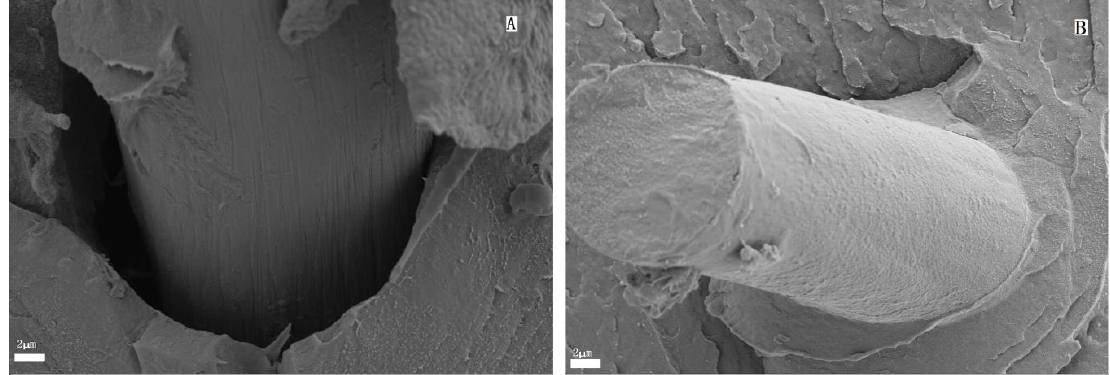
Figure 13. SEM micrographs of the tensile fracture surface of the ( A ) PET/CF and ( B ) PET/PMMA-g-CF composites.